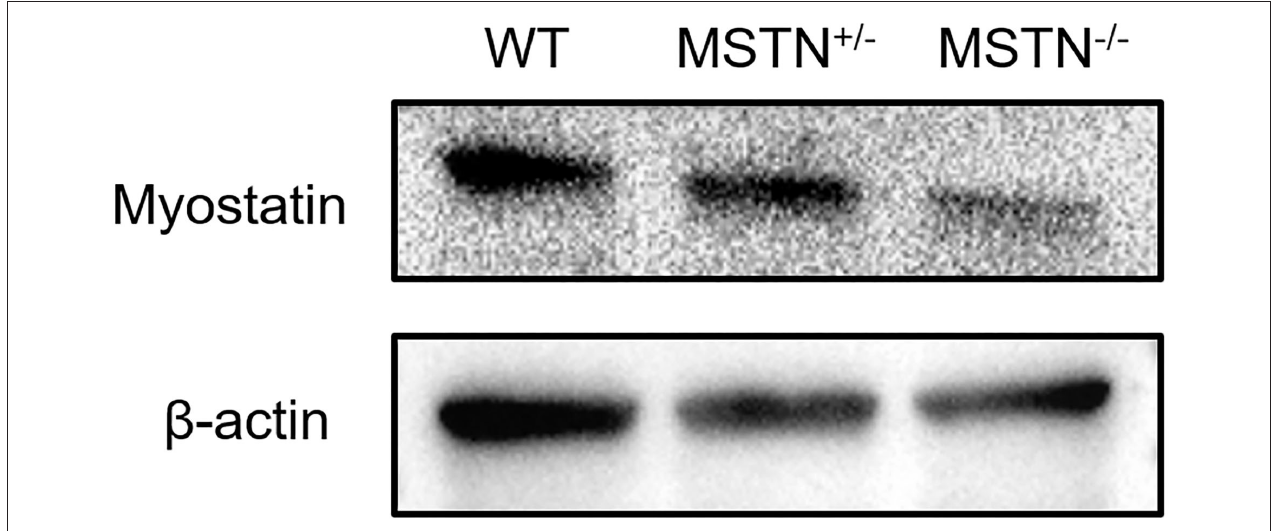
FIGURE 6 | Result of MSTN + /–, MSTN–/– and WT rabbits in Western Blot. Beta-actin served as a loading control (The picture has been cropped).